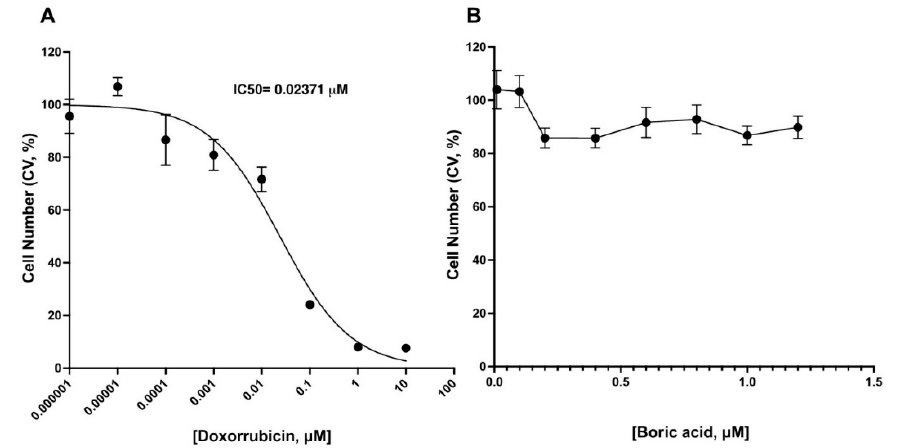
Figure 7. The e ff ect of control drugs on the 4T1 cells. ( A ). Doxorubicin (positive control) induced a concentration-dependent decrease in 4T1 cell viability. ( B ). Analysis of the e ff ects of boric acid (negative control) on 4T1 cell viability. Analysis was performed in triplicate. Data are presented as the mean ± standard error (SE).